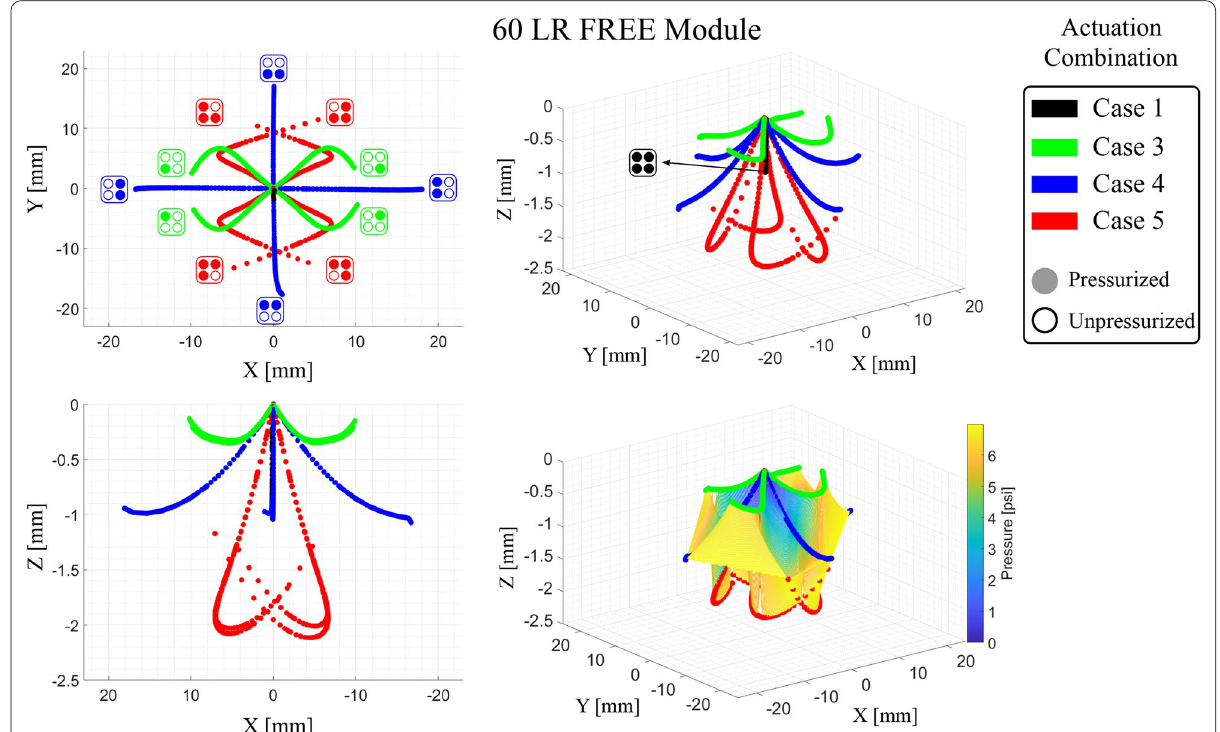
Fig. 10 Orthogonal and three-dimensional views of the reachable end-effector positions for 60 LR-module. The plots show the paths taken by the module’s end-effector as the FREEs are pressurized from 0 to 7 psi based on actuation cases 1, 3, 4, and 5. The variations of each case are shown with activation indicators (top view of the end-effector consistent with Fig. 6) in the X-Y and X-Z planes. The plot in the bottom right illustrates the linearly interpolated estimate of the workspace of the module. All FREEs are modeled with 130 mm length, 9.52 mm inside diameter, and 0.8 mm wall